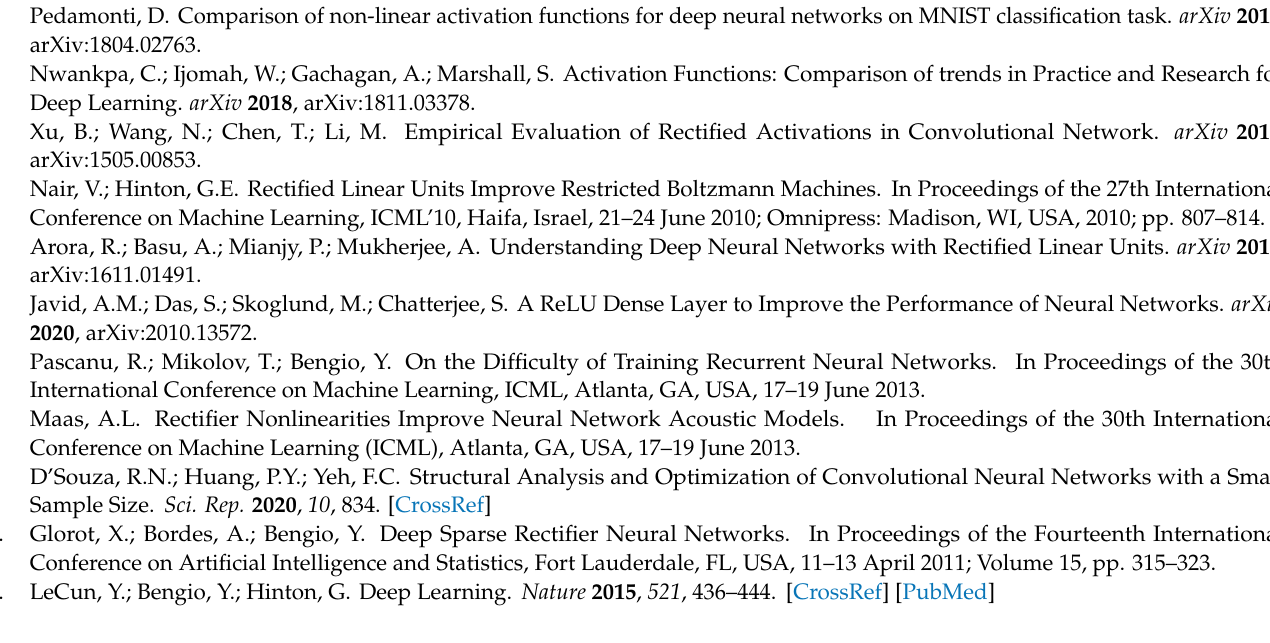
In Table A2, the input dimension for the first layer was changed according to the number of features in the continuous data (8, 16 or 24). In Table A3, for EMNIST-letters data, the output layer was changed to 26 nodes (for 26 classes in the data set) while for MNIST-digits and MNIST-fashion data it was